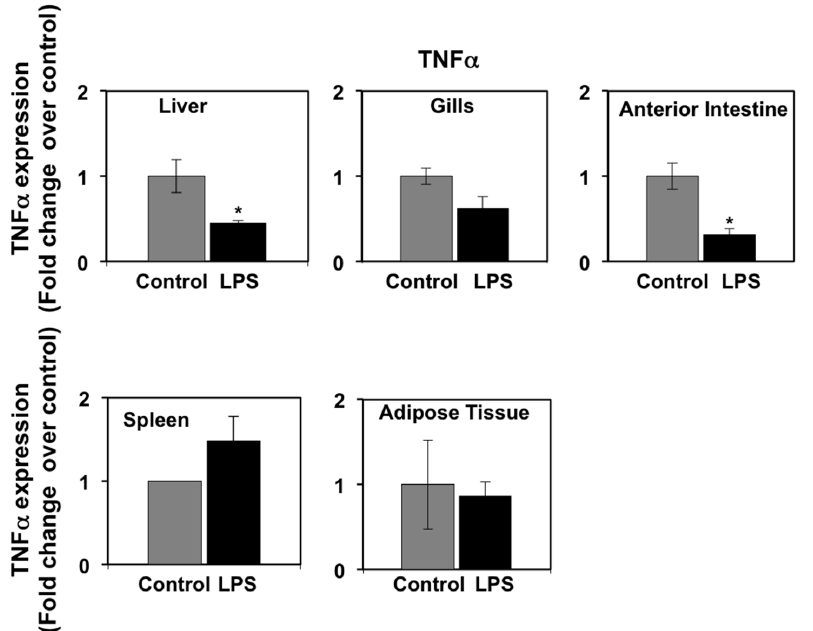
Figure 3. Effects of lipopolysaccharide (LPS) administration in vivo on TNF α gene expression in seabream tissues. The mRNA expression levels of TNF α were measured by qPCR in seabream tissues at 72 h after LPS administration. Results are expressed as fold induction over the control (saline-injected) group, which was set to 1, and shown as means ± SE of five fish per group, with each sample performed in triplicate. Asterisks indicate significant differences from control ( p < 0.05 ).